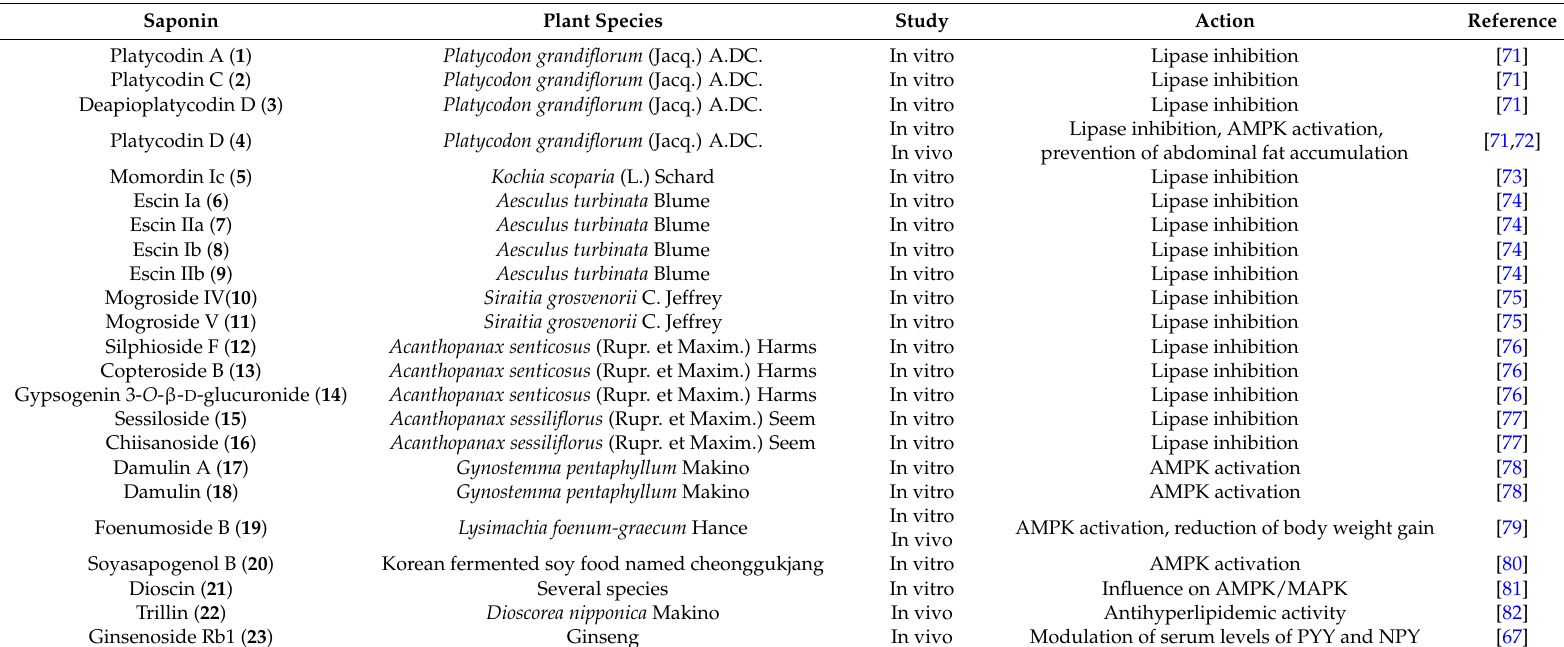
Table 2. Saponins with anti-obesity